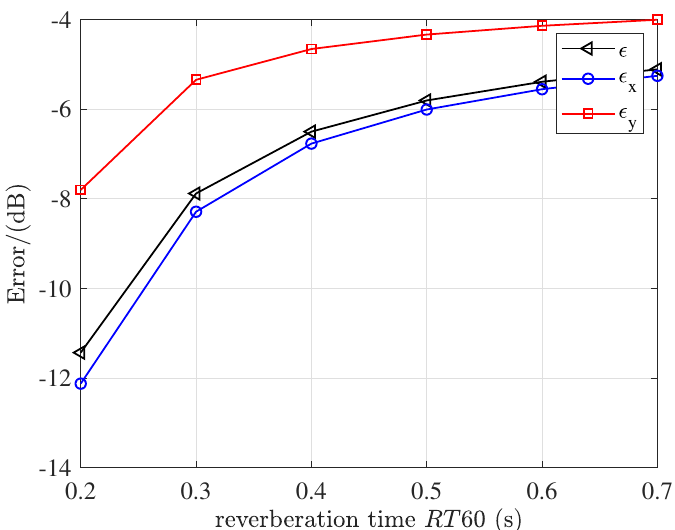
Figure 3. The NMSE of the reproduced intensity at control points under different reverberation times. The tuning parameter τ = 0.5 and the control filter length J = 400.